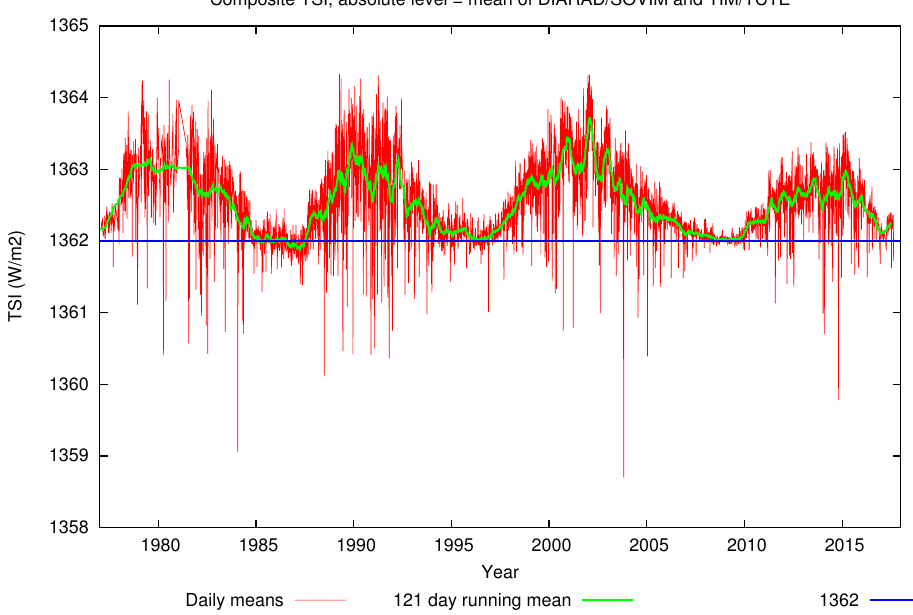
Figure 1. Composite Total Solar Irradiance (TSI) at the mean absolute level of DIARAD/SOVIM and